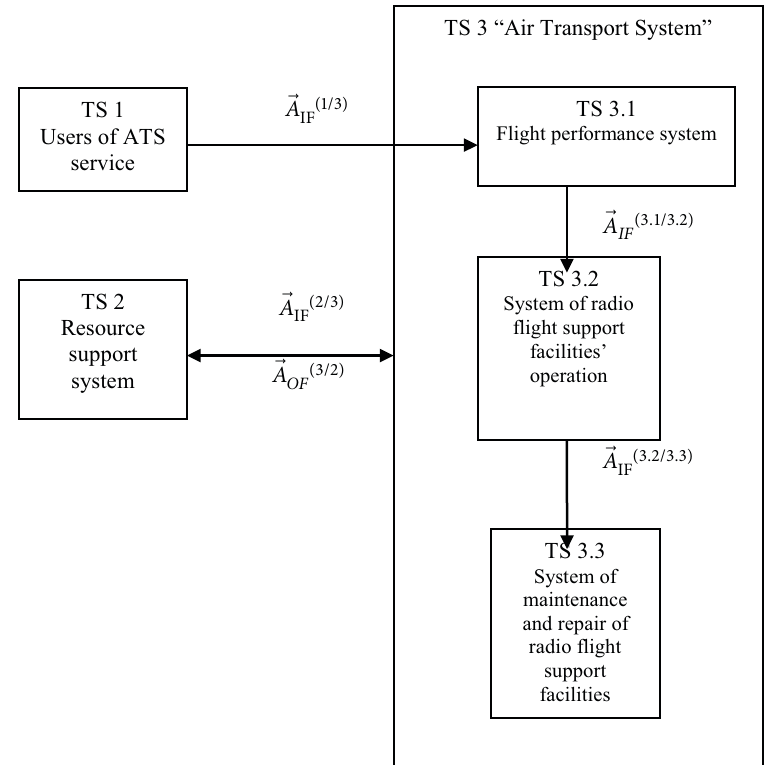
Fig. 1. Generalized structural diagram of the interaction between the technological systems in the